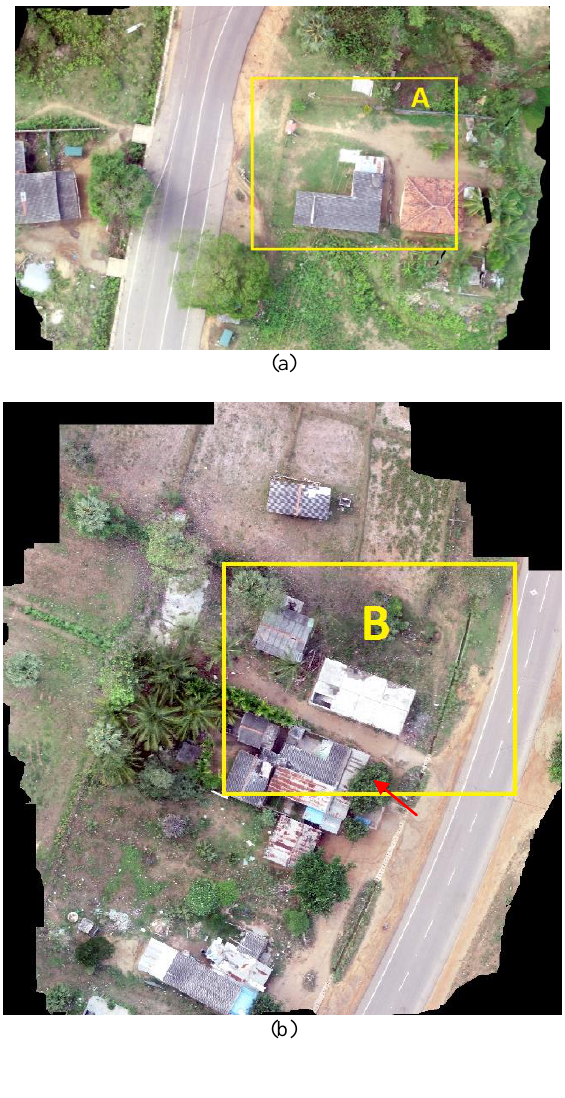
Figure 5: Ortho-mosaic after image